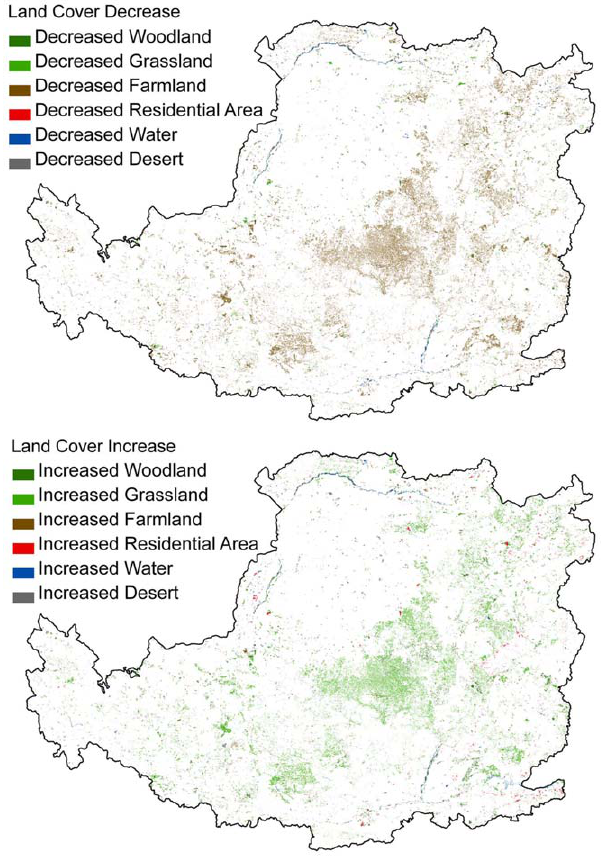
Figure 3. Decreased (above) and increased (below) land covers from 2000 to 2008.